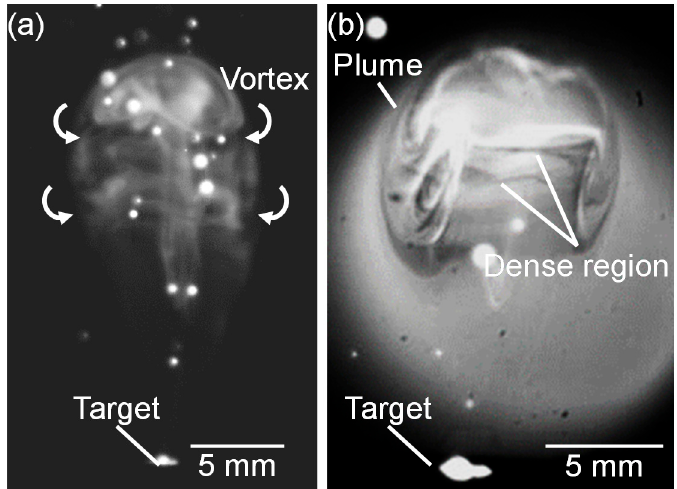
Figure 13. ( a ) Magnified high-speed camera images of plume propagation captured at 13.4 ms and 101 kPa, and ( b ) corresponding shadowgraph.